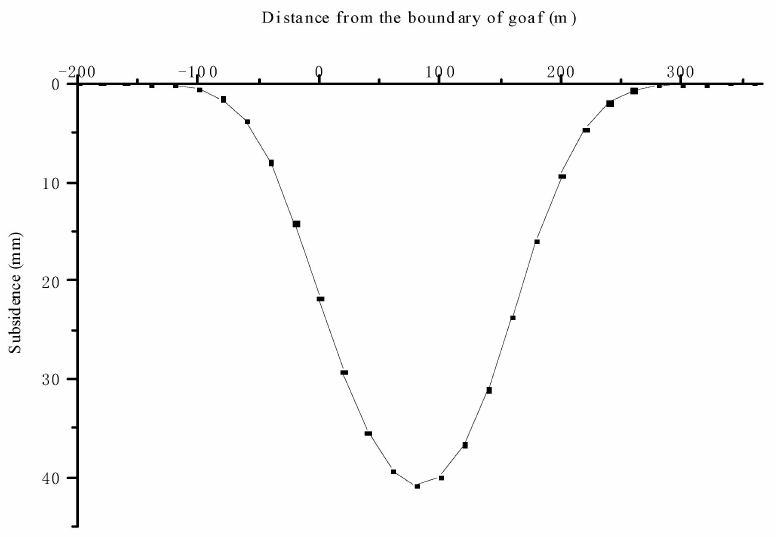
Figure 10. Predicted curve of surface